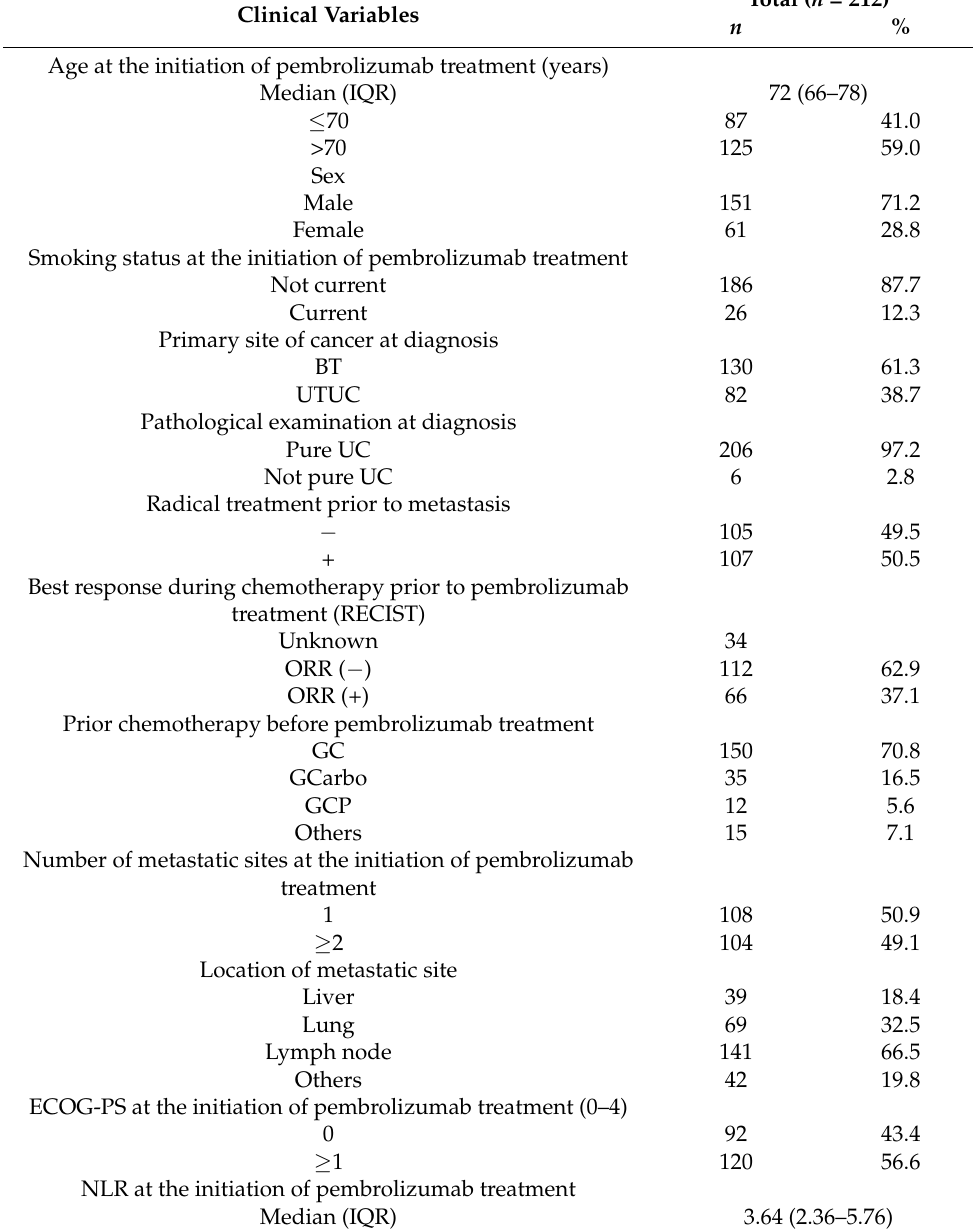
Table 1. Clinical variables in 212 patients with advanced platinum-resistant